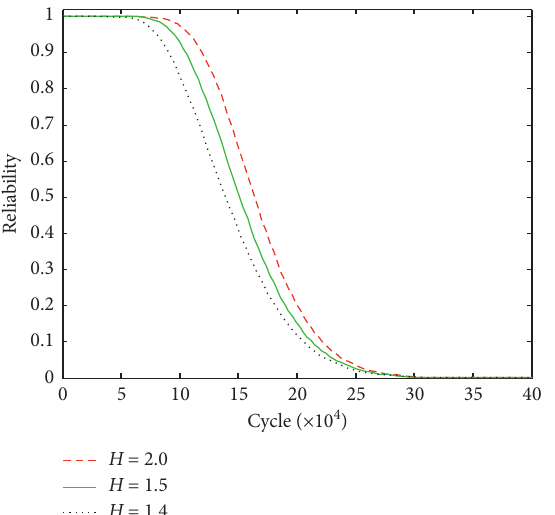
Figure 7: Sensitivity analysis of R ( t ) and on H .